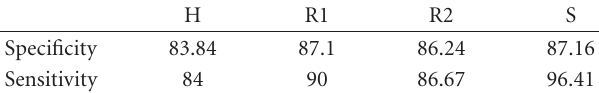
Figure 4: One of the splittings of a lesion and the whole curve of distances. Table 1: Evaluation of classification